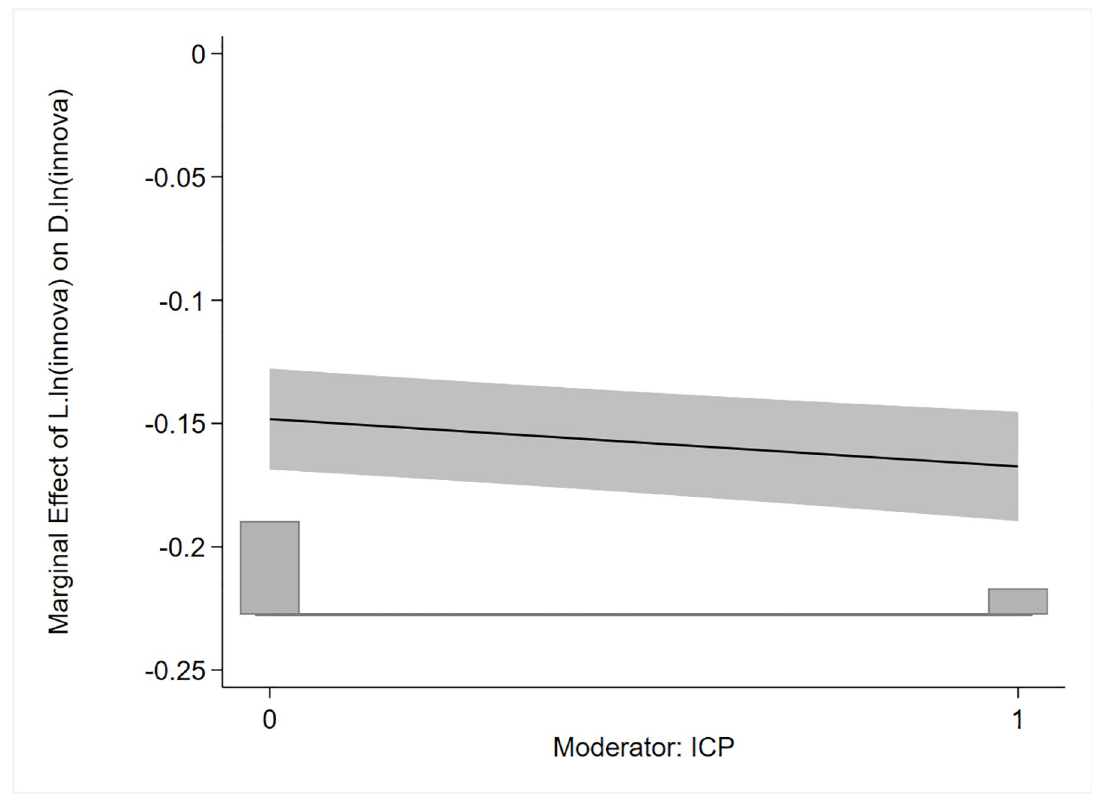
Fig 2. Moderating effect of the pilot policy on innovation